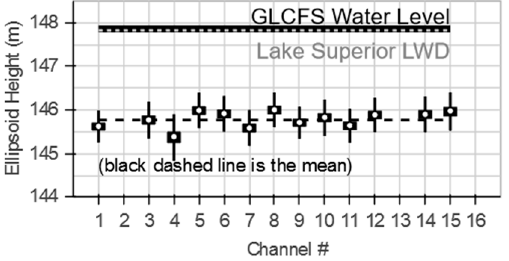
Figure 7. Channel-specific biases were observed in the mean surface elevations. The biases are the differences between the average surface photon elevation and the elevation of the actual water level, as modeled based on a Great Lakes Coastal Forecasting System (GLCFS) water level point query. The range of values for each channel are shown as vertical bars.